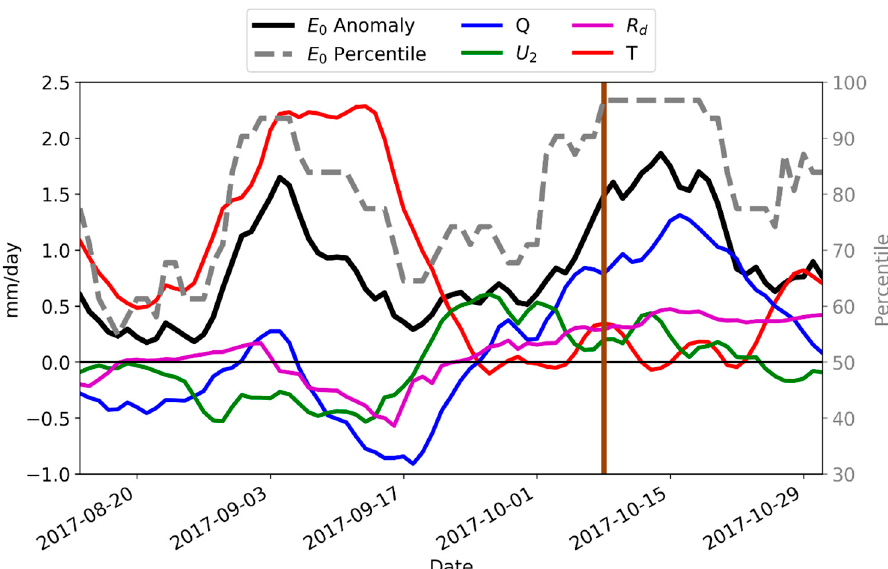
Figure 8. Attribution of evaporative demand (E 0 ) anomaly prior to and during the Tubbs Fire in Sonoma County, California, into contributions from each of its meteorological and radiative drivers. The 2-week E 0 anomaly (black line) is spatially averaged across Sonoma County. The contributions from each of its drivers are shown as colored lines (temperature (T) in red, specific humidity (Q) in blue, downwelling shortwave radiation (R d ) in purple, wind speed (U 2 ) in green); percentiles of 2-week E 0 are shown in dashed grey (right-hand axis); and the ignition date of the Tubbs Fire is shown as a vertical brown line.